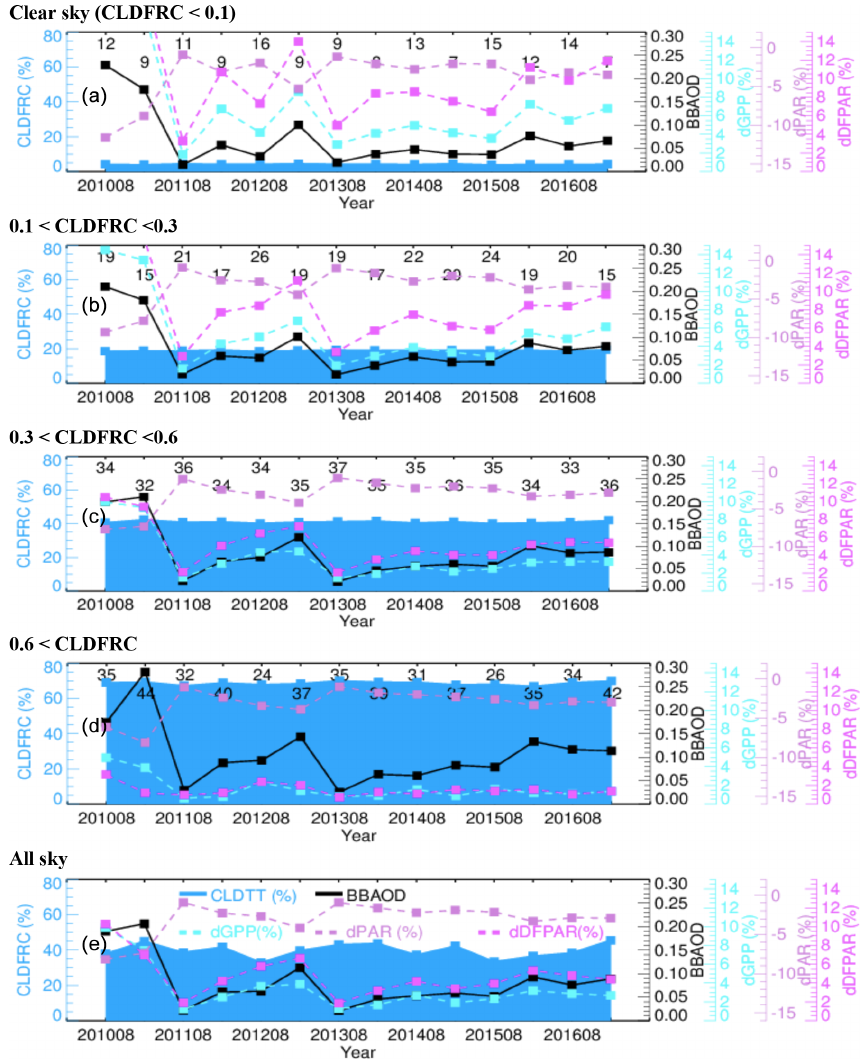
Figure 13. Monthly (August and September) averaged fields during 2010–2016 over the Amazon range (25 ◦ S–5 ◦ N, 80–30 ◦ W) for dif- ferent cloudy conditions. The fields shown here are CLDFRC (shaded area), biomass burning aerosol optical depth (BBAOD, black solid line), and the changes in GPP (dGPP), direct (dDRPAR), and diffuse (dDFPAR) fields due to the biomass burning aerosol impact on radiative fields (dashed lines) estimated by the two pair1 experiments. Note that all the changed fields are calculated as d X( % ) = (X (allaer) − X (nobbaer) )/X (nobbaer) × 100 . 0; here X = GPP, DRPAR, or DFPAR. The numbers marked in (a–d) are the frequency of occurrence in percent of the corresponding cloud cover over the Amazon Basin in each month. Note that the dGPP is 119.5% (201008) and 92.6% (201009)in (a) . The dDFPAR is 111.1% (201008) and 105.5% (201009) in (a) and 97.1% (201008) in (b)